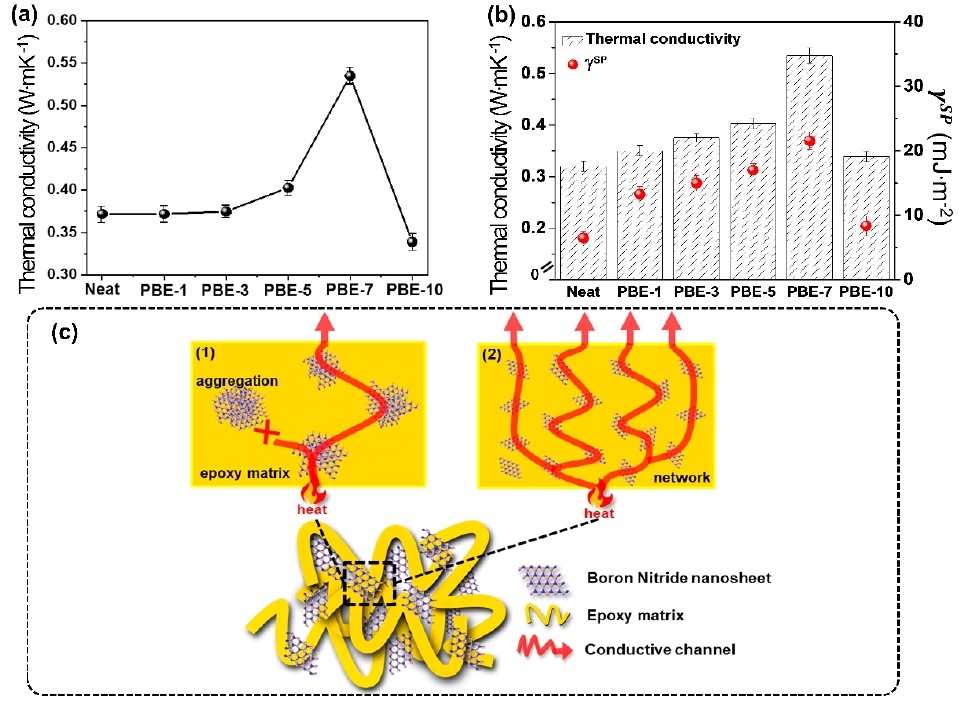
Figure 6. Thermal conductivity of the BNNS/epoxy nanocomposites: ( a ) thermal conductivity, ( b ) correlation between specific polar component of surface free energy and thermal conductivity, ( c ) a schematic representation of thermal conductivity mechanisms of Neat and PBE-7.